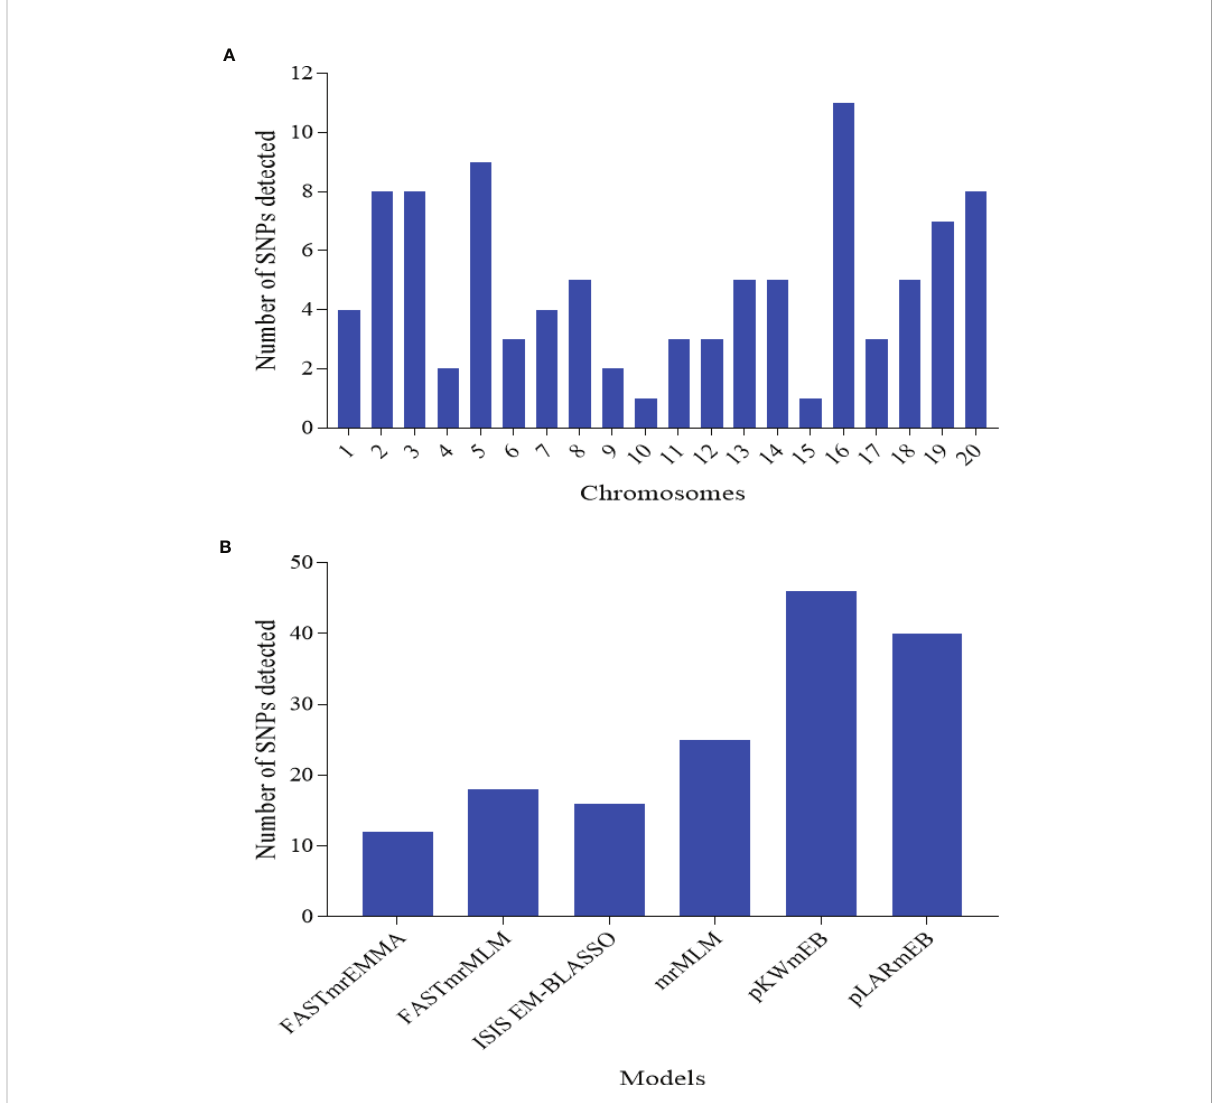
FIGURE 3 Number of signi fi cantly associated single nucleotide polymorphism (SNP) markers detected for the nine traits associated with leaf spot diseases rating. (A) SNPs detected on each chromosome of the two sub-genomes. A sub-genome comprised chromosome (Chr) 1 to 10, while B sub-genome consisted of Chr11-20. (B) SNPs detected by each of the six multi-locus models implemented in this